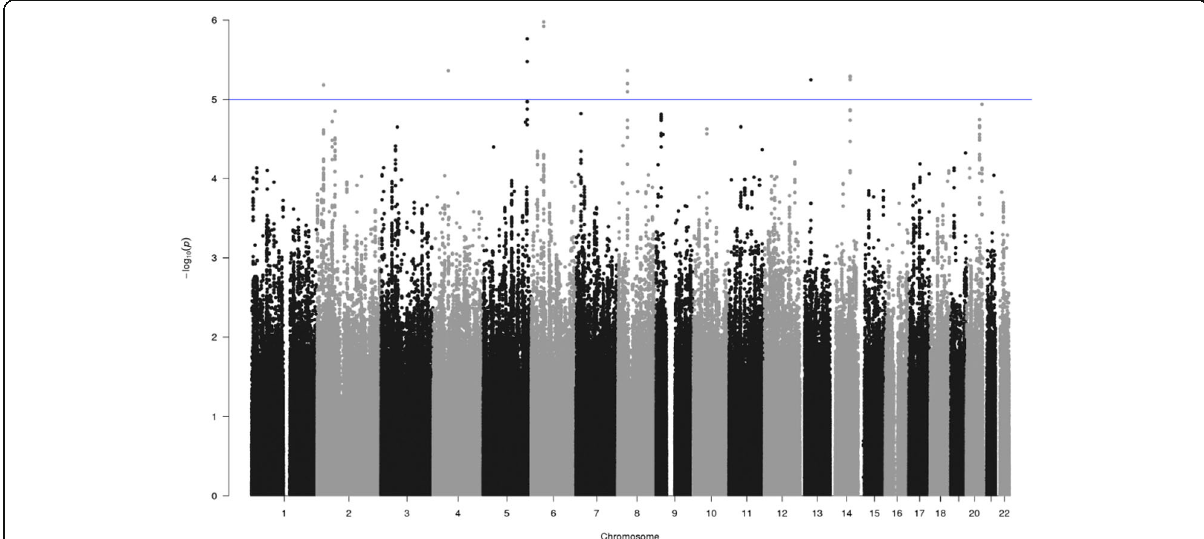
Fig. 1 pQTL analysis of SNPs associated with circulating ANGPTL3 at baseline. Manhattan plot of pQTL analysis of SNPs associated with circulating ANGPTL3 at baseline. Each SNP is indicated by a black or a gray dot. They are arranged by chromosomal location ( x -axis). The y -axis illustrates the level of statistical significance measured by the negative log of the corresponding p value for each SNP. The blue line represents suggestive association ( p < 1 × 10 − 5